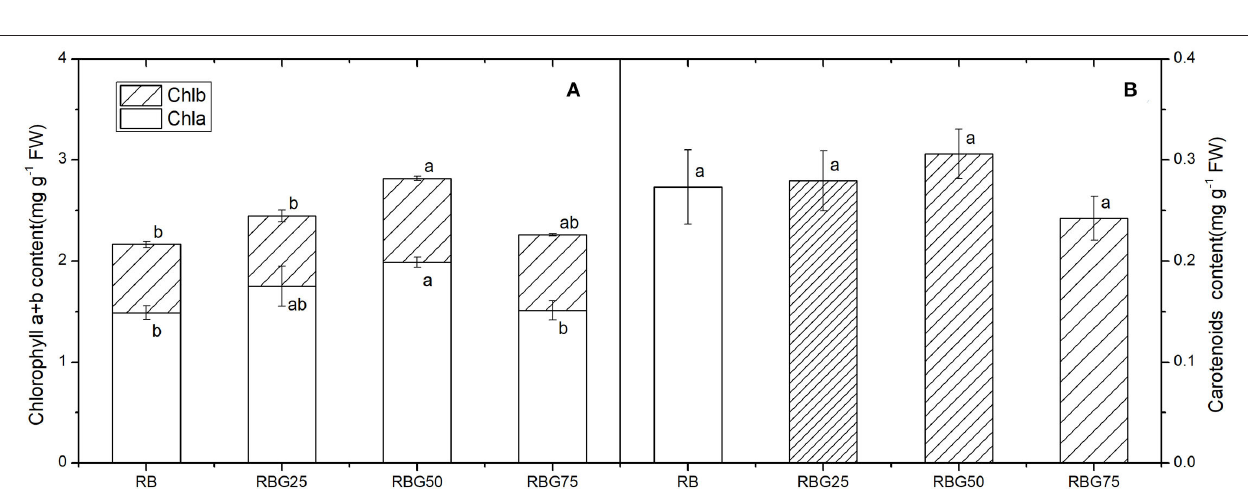
gene) are shown in Figure 9 . After 9 days of drought treatment, the transcript levels of CsGAD2 were upregulated and the transcript levels of CsALMT9 were downregulated by green light partial replacement of red light and blue light ( Figures 9A,B